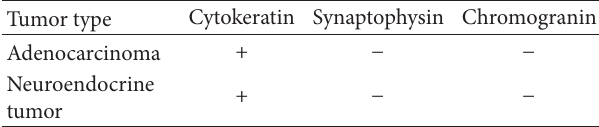
Figure 3: The carcinoma cells are strong and diffusely positive for synaptophysin. Table 1: Differential diagnosis with corresponding